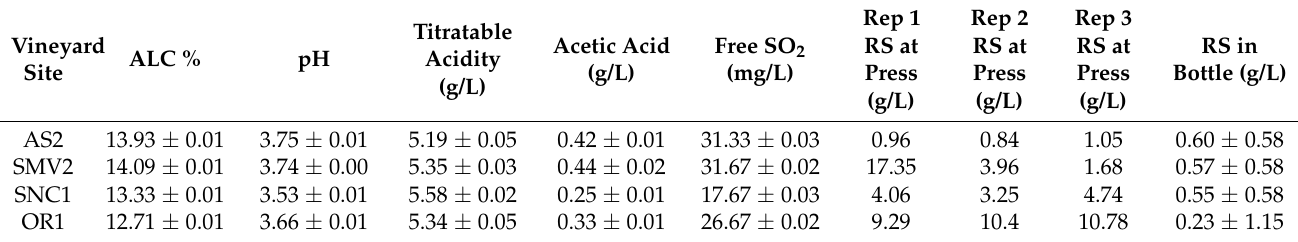
Table 3. Final wine chemistry of the blended fermentation replicates. Blends were made after malolactic fermentation by aggregating wine in the four replicate fermentation vessels. Residual sugar (RS) is an indication of fermentation “completeness”. RS is reported for each biological replicate across vineyards. Standard chemical measurements for finished wine are presented for each vineyard site as a mean of the blended fermentation replicates, along with the standard deviation for each set of technical